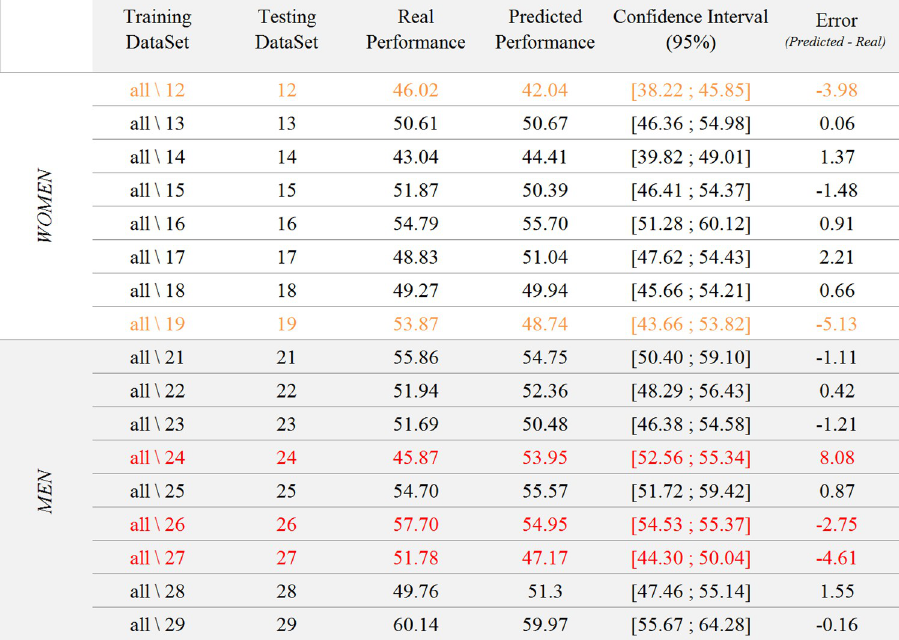
Fig 7. Results of the test of the 17 models generated from the training datasets on their respective testing datasets. The table shows training and testing datasets, the real performance of the testing dataset, the predicted performance of the testing dataset with the corresponding confidence interval, as well as the error of the